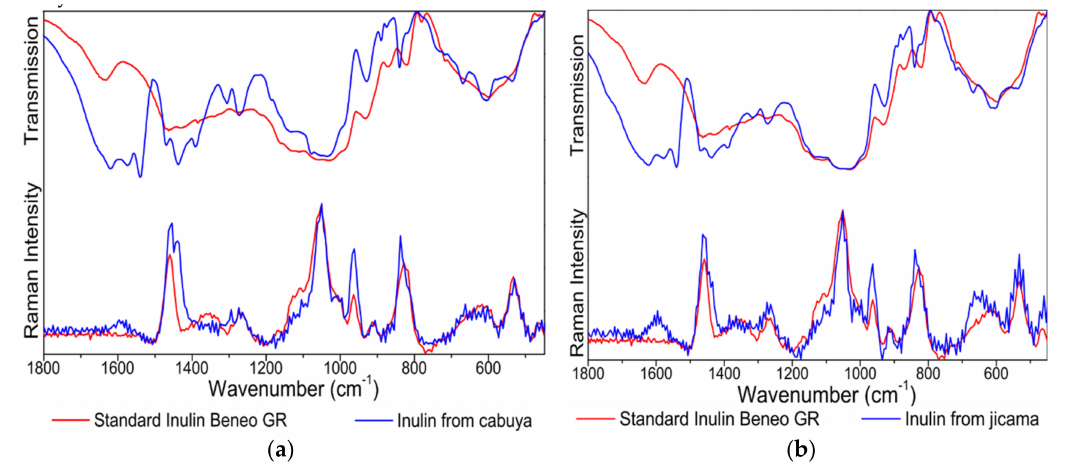
Figure 6. Comparison of the IR and Raman spectra of standard inulin and inulin from: ( a ) jicama and ( b )